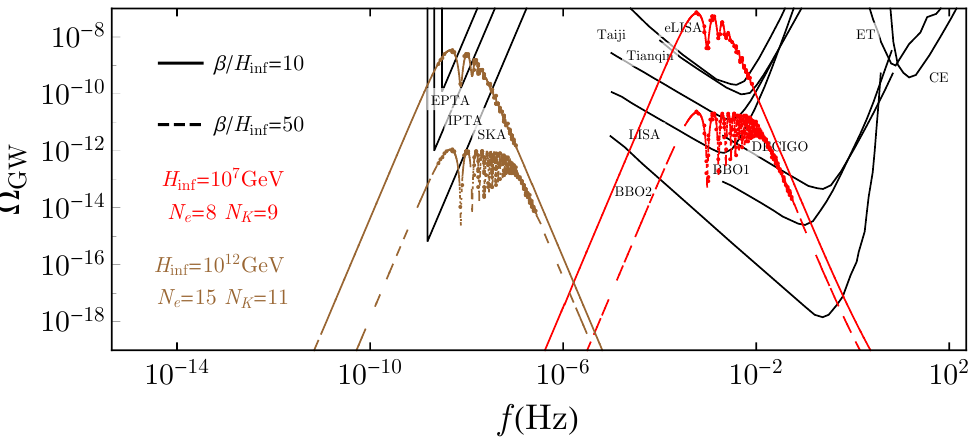
Figure 12 . The GW spectrum Ω GW in the dS × t ˜ p =1 / 3 -RD scenarios for different parameter sets. The solid line represents β/H inf = 10 and the dashed line is for β/H inf = 50 . The red line has parameters H inf = 10 7 GeV, N e = 8 and N K = 9 and the brown color has parameters H inf = 10 12 GeV, N e = 15 and N K = 11